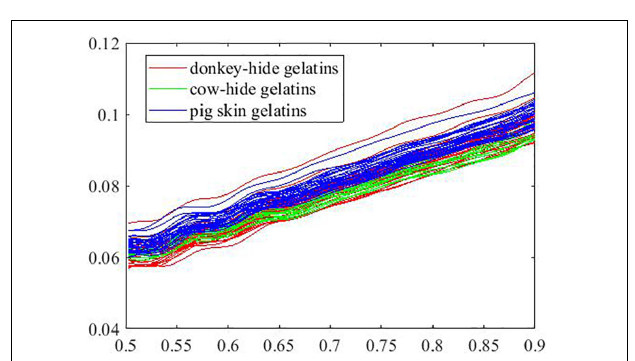
FIGURE 8 | Extinction coefficient of samples in Part